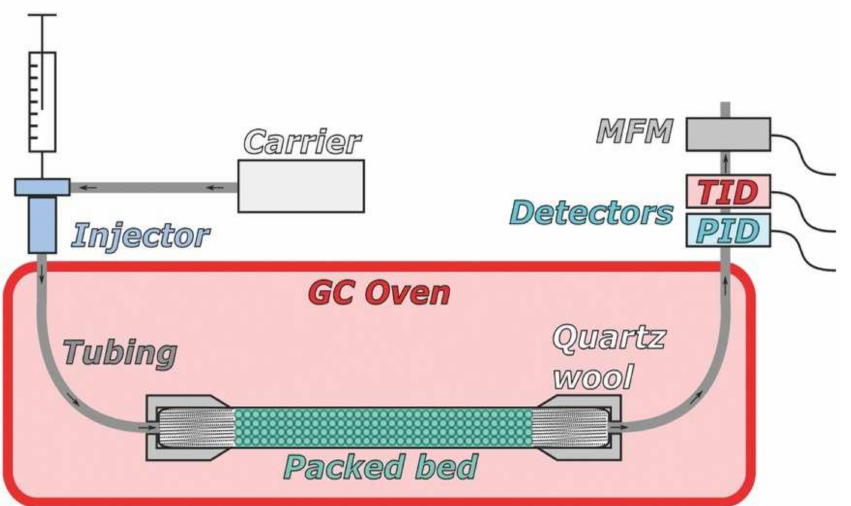
Figure 1. Schematic depiction of the IGC setup. Pressure sensors (before and after packed bed) and electronic pressure controller (before injector) omitted for clarity. MFM: mass flow meter. Reprinted with permission from [38] Copyright (2018)